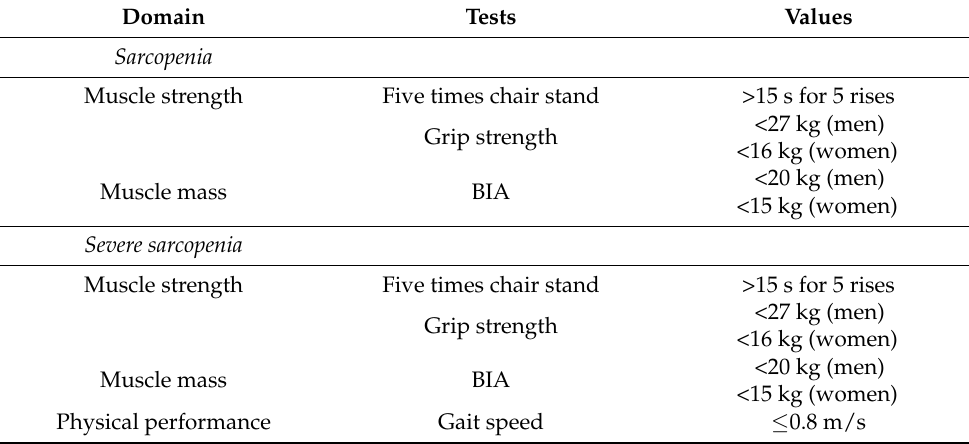
Table 3. Classification for Sarcopenia cut-off